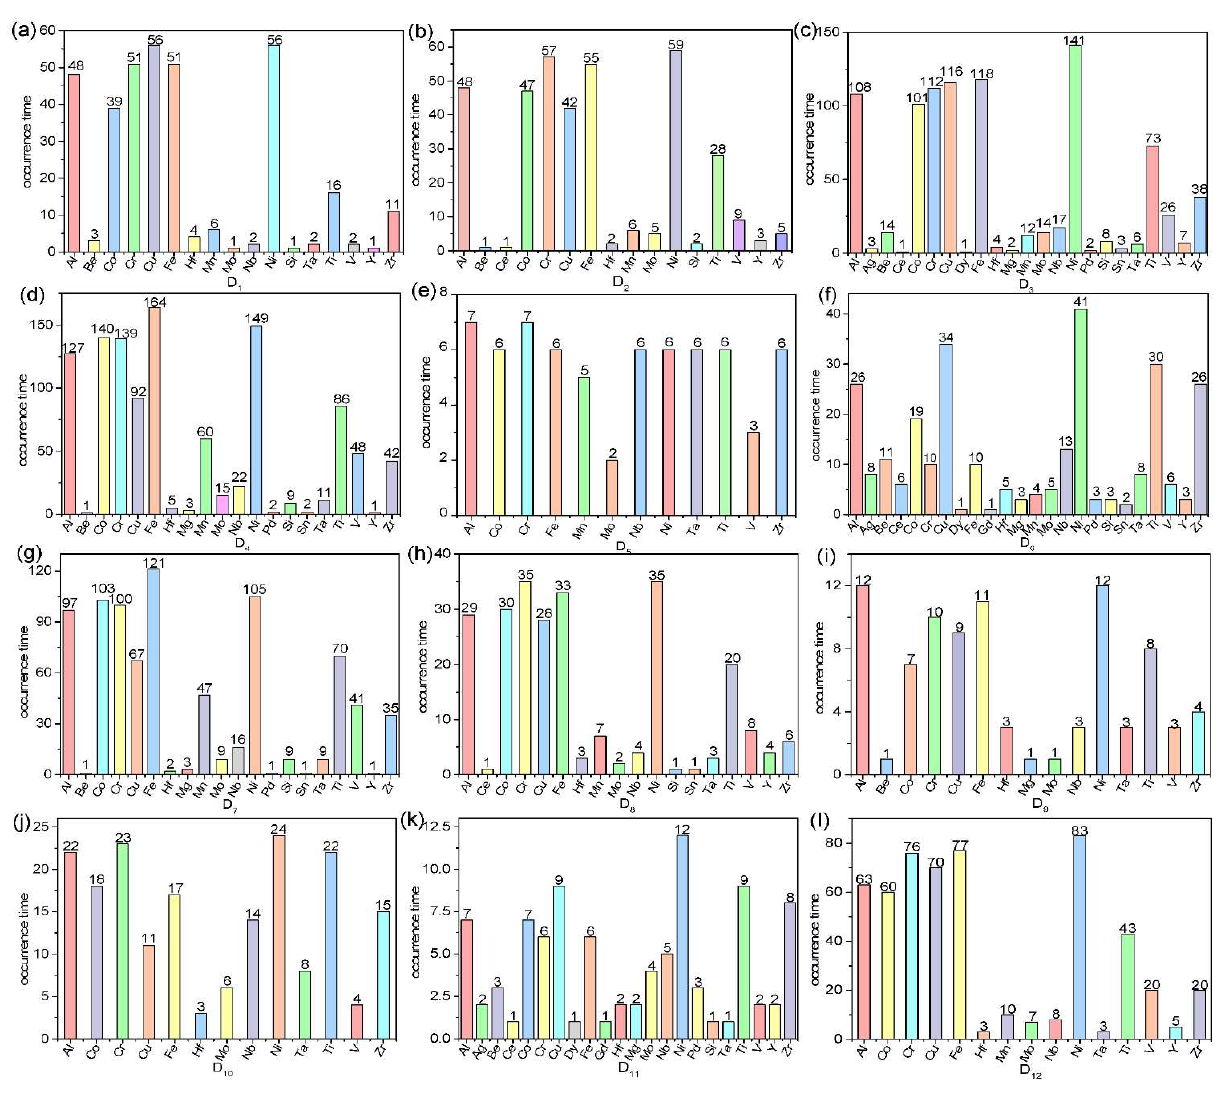
Figure 6. Statistics of the occurrence time of each element in 12 datasets. ( a ) D1, ( b ) D2, ( c ) D3, ( d ) D4, ( e ) D5, ( f ) D6, ( g ) D7, ( h ) D8, ( i ) D9, ( g ) D10, ( k ) D11, ( l ) D12. Table 1. Maximum values and minimum values of the five